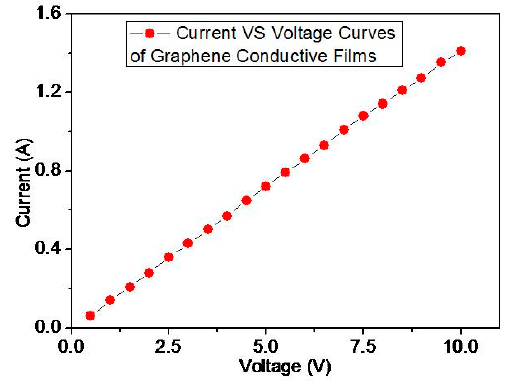
Figure 6. I-V curve of the graphene.